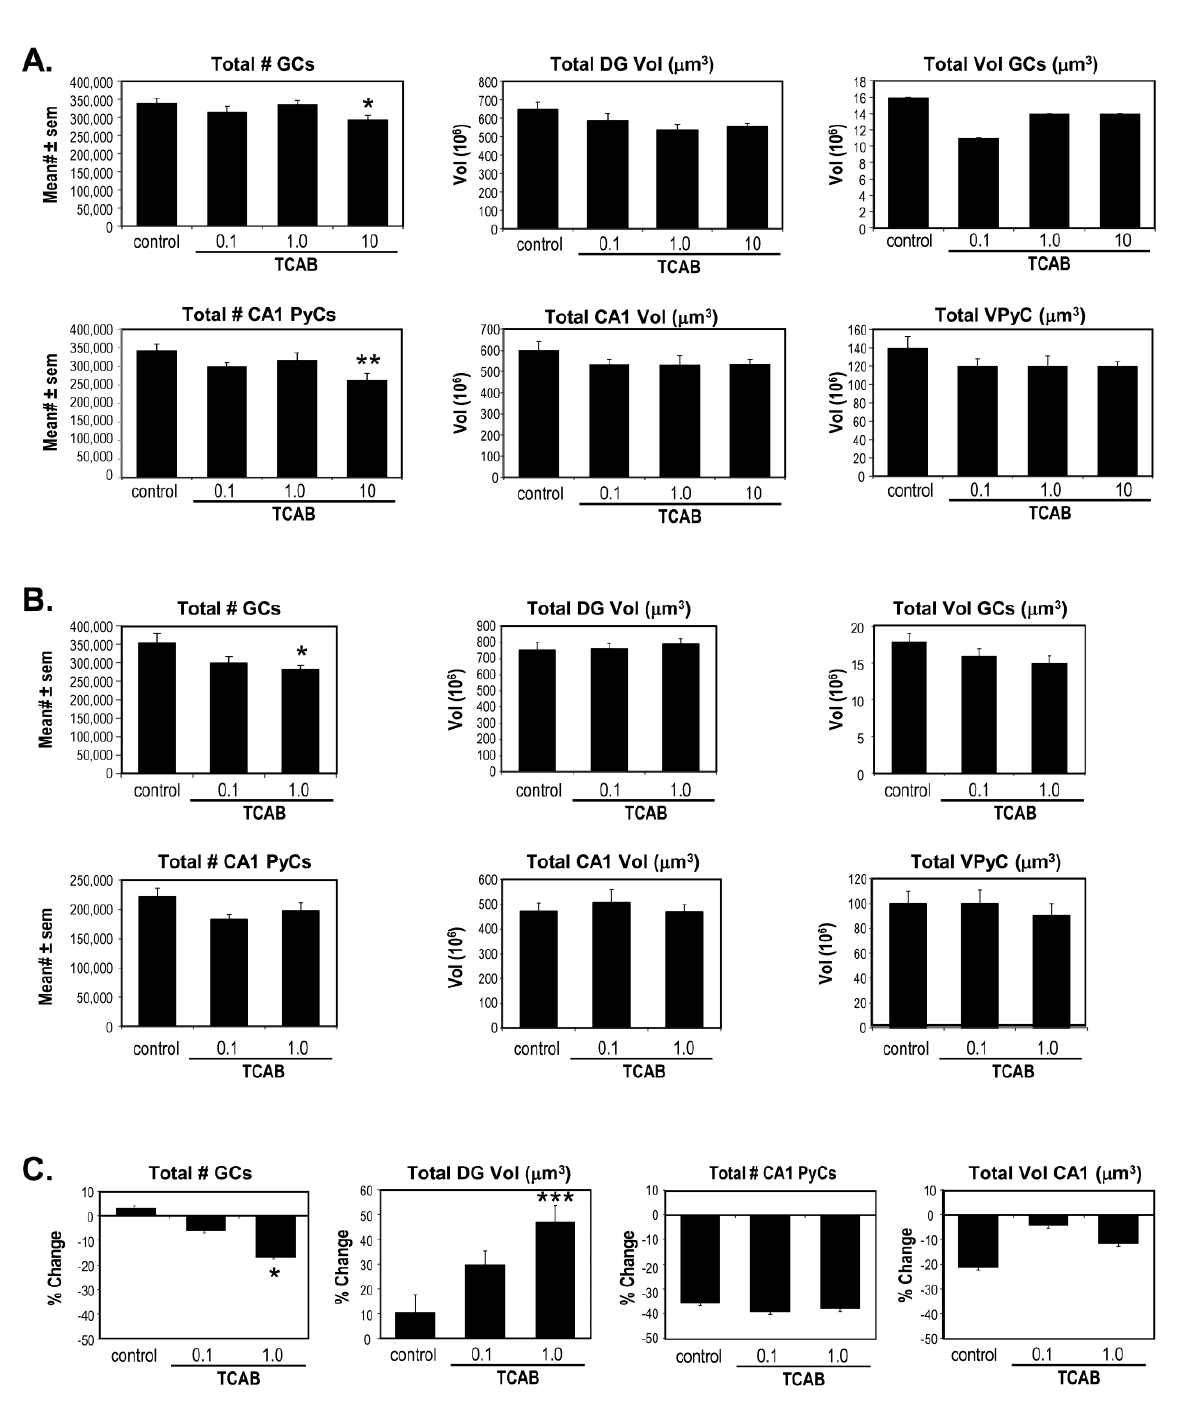
Figure 11. Unbiased stereology of hippocampal dentate granule cell region (DG) and CA1 pyramidal region in ( A ) PND21 and ( B ) PND150 male rats following developmental exposure to TCAB. Total number of dentate granule cells (GC) and CA1 pyramidal cells (PYCs), Total volume of DG and CA1, and total volume of the GCs and CA1 pyramidal cells (VPyC); ( C ) % change from PND21 to PND150. Data represents mean ±